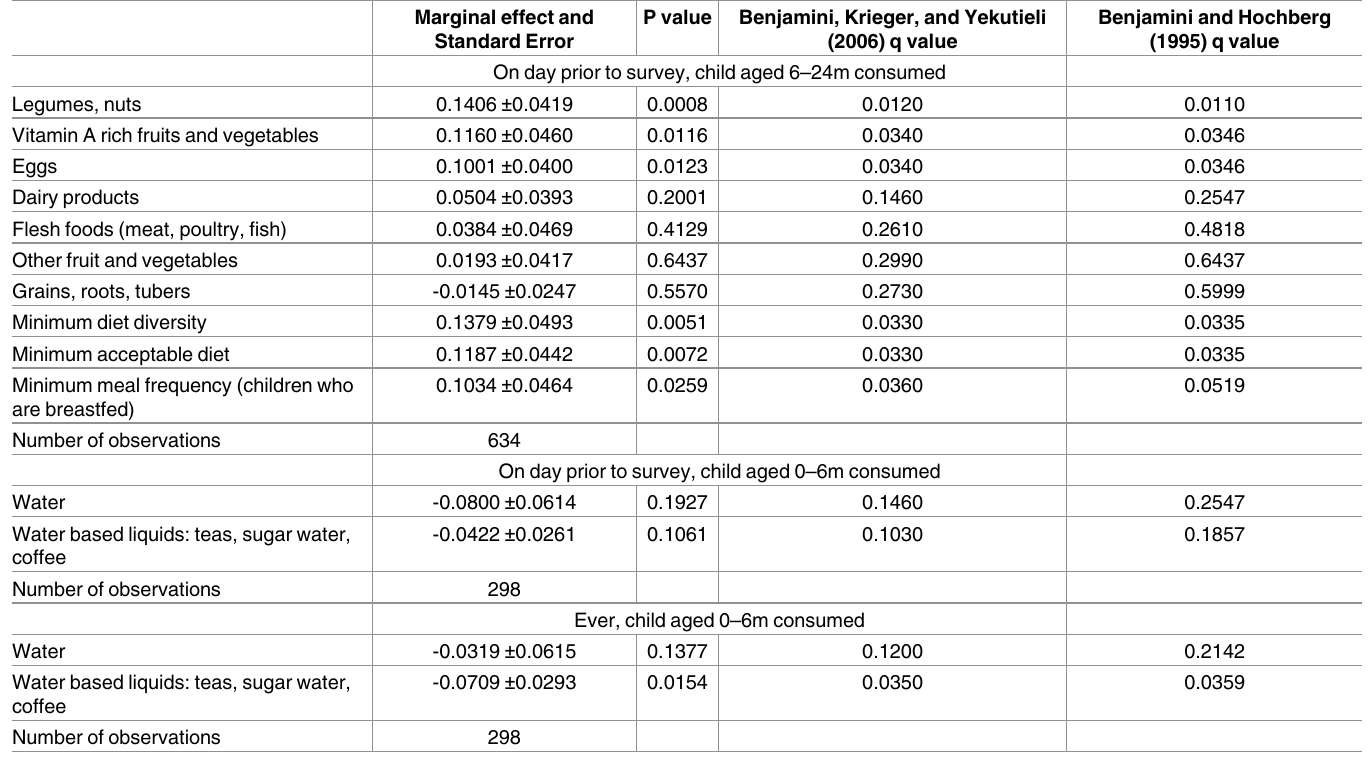
Table 3. Impact of exposure to neighbor’s BCC on infant and young child feeding practices, marginal effectscalculated from probit regression with clustered standard